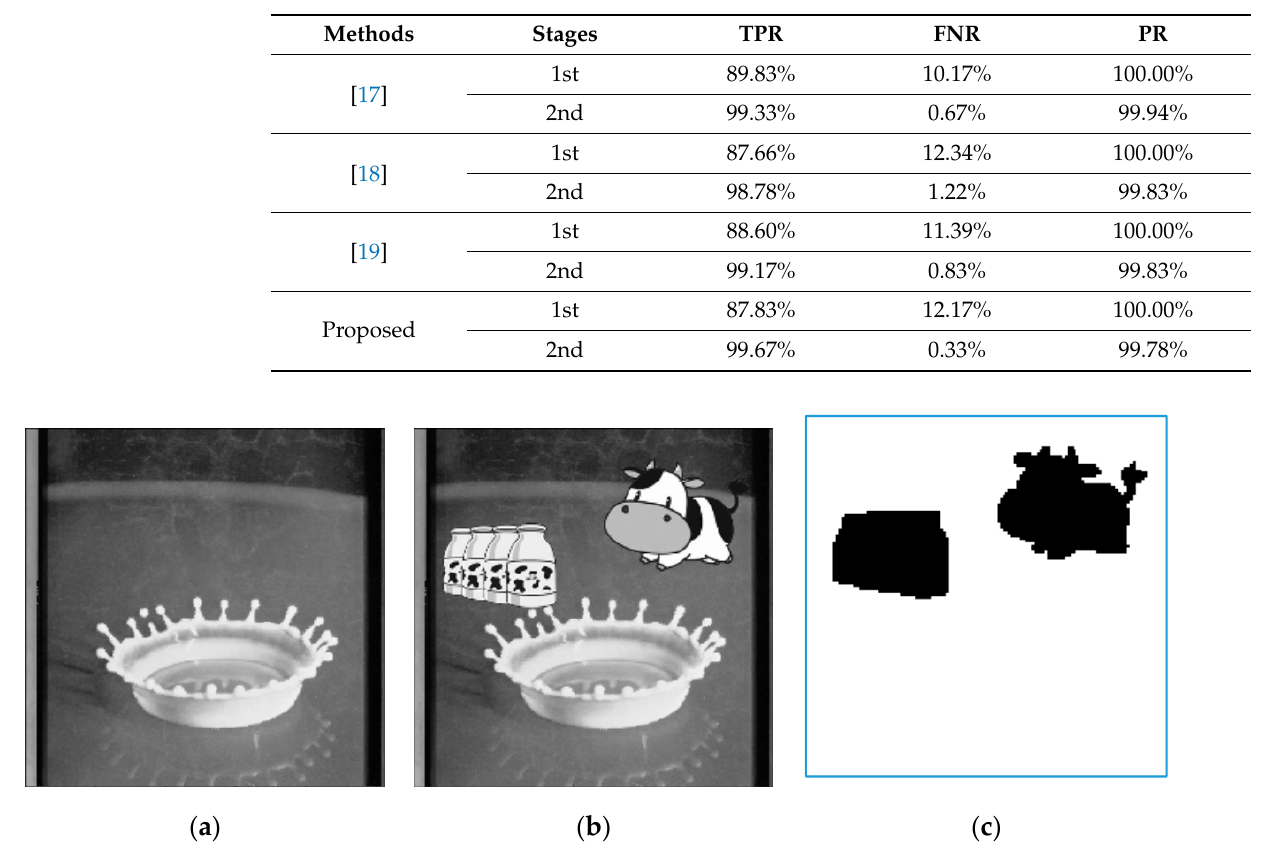
Table 6. Comparisons of different methods of TPR, FNR, and PR.